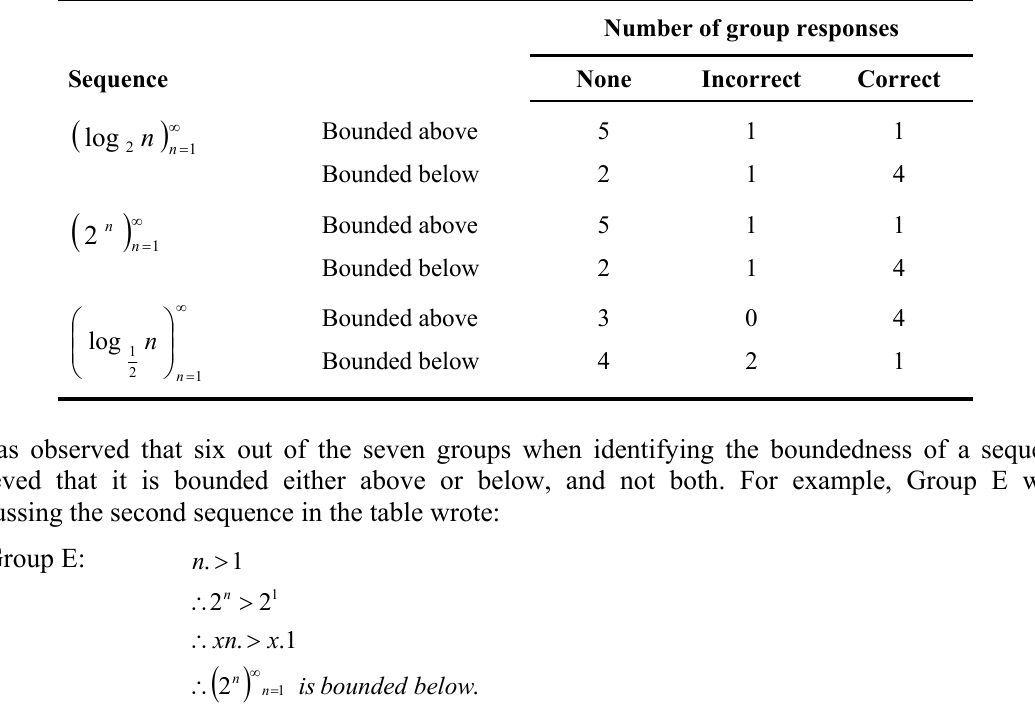
Table 3 : Results on verifying and refining concepts bounded below/above (N =